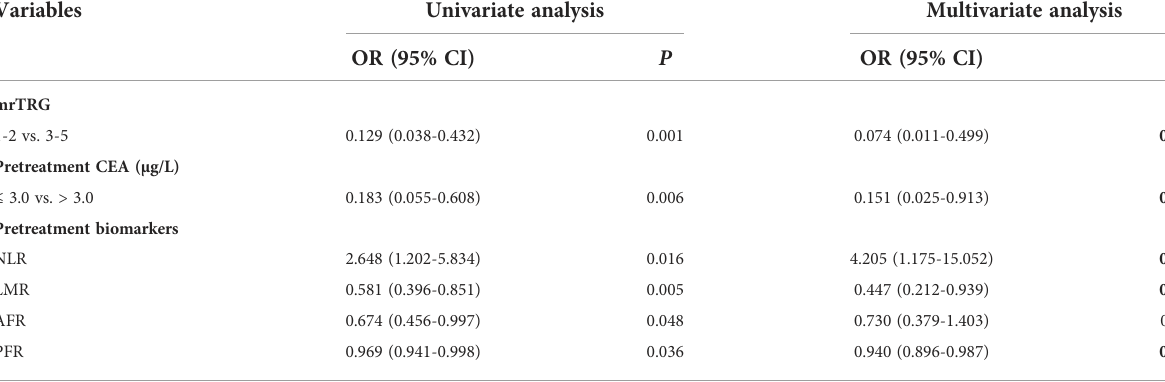
TABLE 3 Univariate and Multivariate Logistic regression analysis for response to